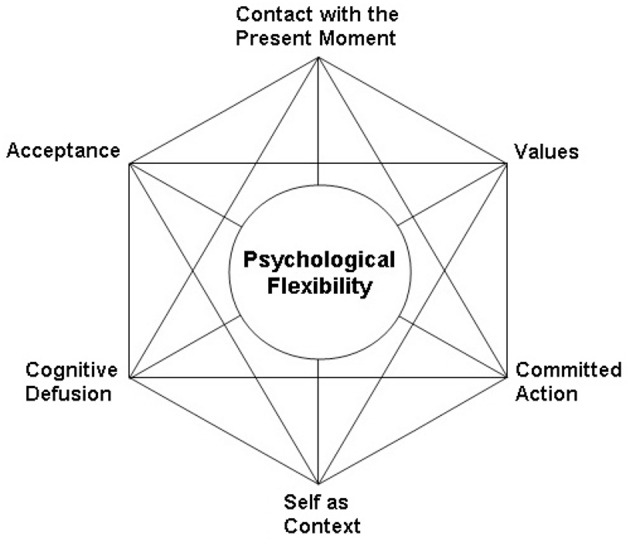
The ACT hexaflex.